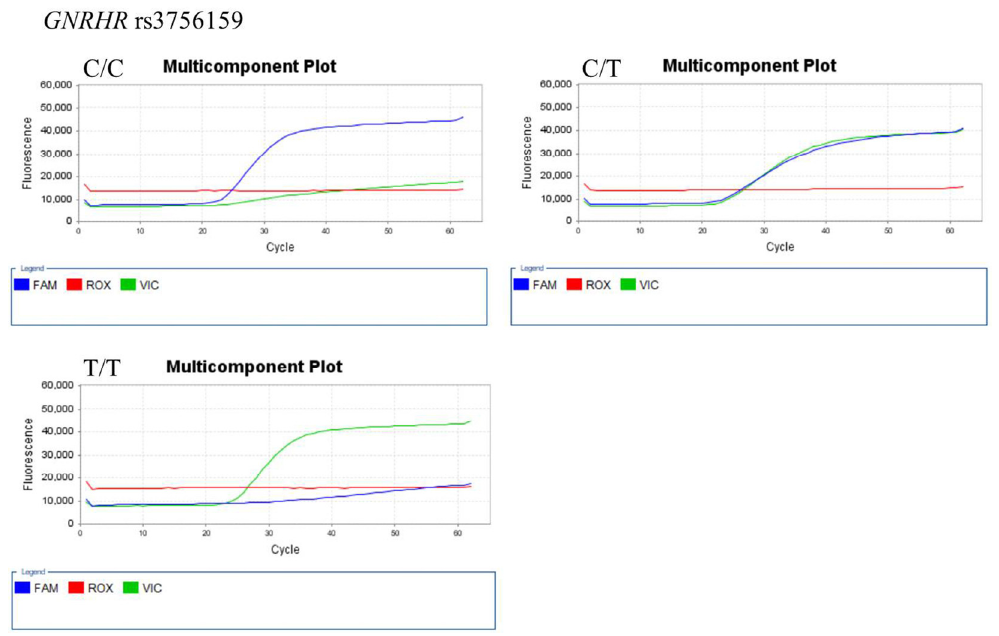
Figure 4. Representative TaqMan assay for GNRHR (rs3756159) genotyping. The FAM (blue) and VIC (green) fluorescence probes detect C and T alleles, respectively. The ROX (red) fluorescence probes is used for calibration. Table 2. The frequencies of AMH 146T > G (rs10407022) SNP among women with serum AMH < 1.2 ng/mL in varied age groups.